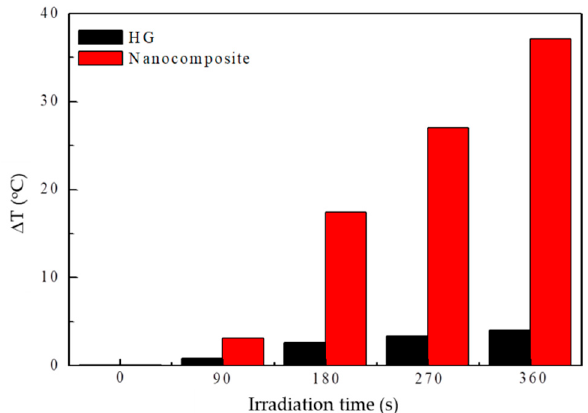
Figure 2. Effect of RF (30 kHz, 1000 W) irradiation on the hydrogel matrix (HG, black bars) and the nanocomposite (red bars) produced by formation of Crosslinked thermosensitive hydrogels of poly( n -isopropyacrylamide) (cPNIPAM) around PANI nanoparticles (stabilized with polyvinylpyrrolidone (PVP)). The temperature was measured with a thermographic camera.